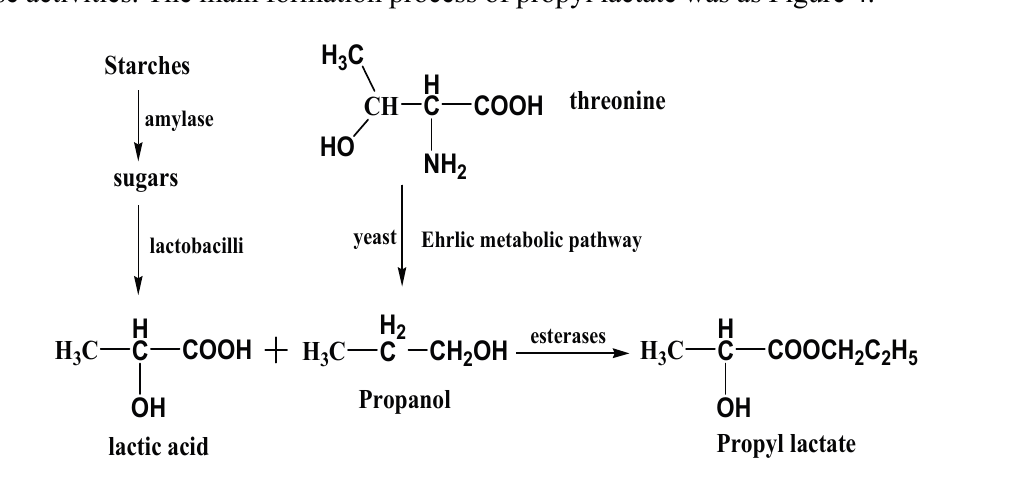
Figure 4. The pathway of propyl lactate formation by esterase